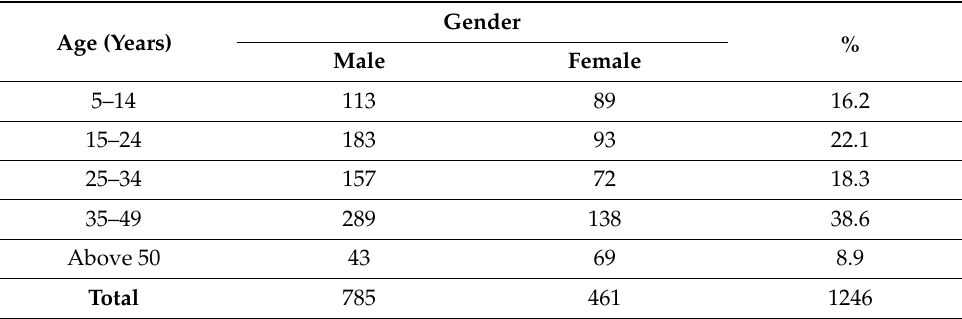
Table 1. Age-scale of the patients with negative COVID-19 PCR